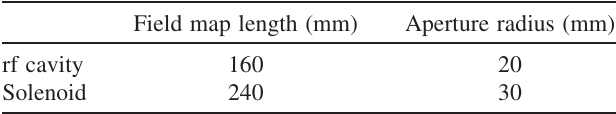
TABLE I. Physical properties of devices.